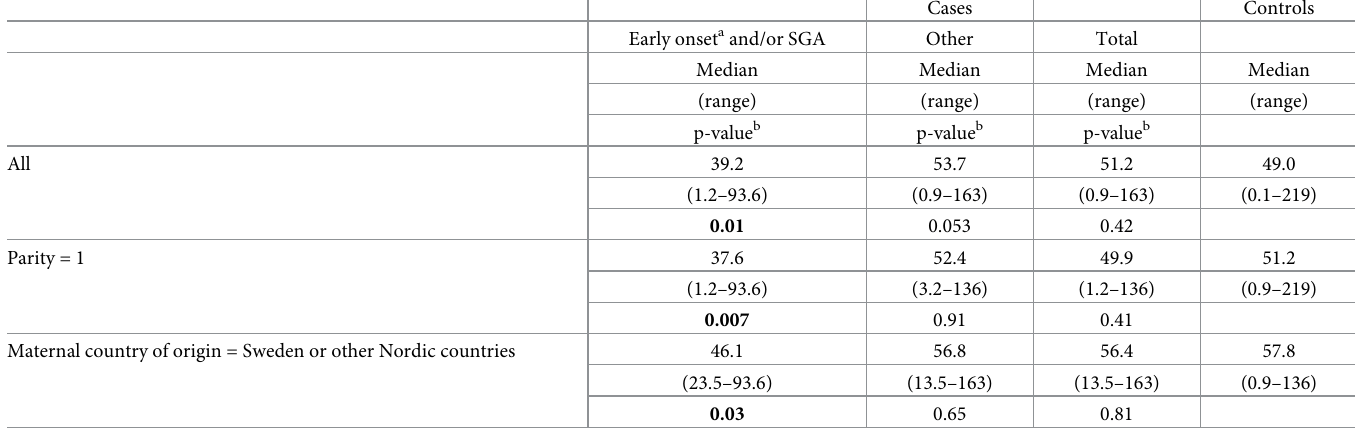
Table 2. Median levels with range of vitamin D (25-hydroxyvitamin D3, nmol/L) among preeclampsia cases and controls. In addition, p-values from the comparisons with the controls are shown.